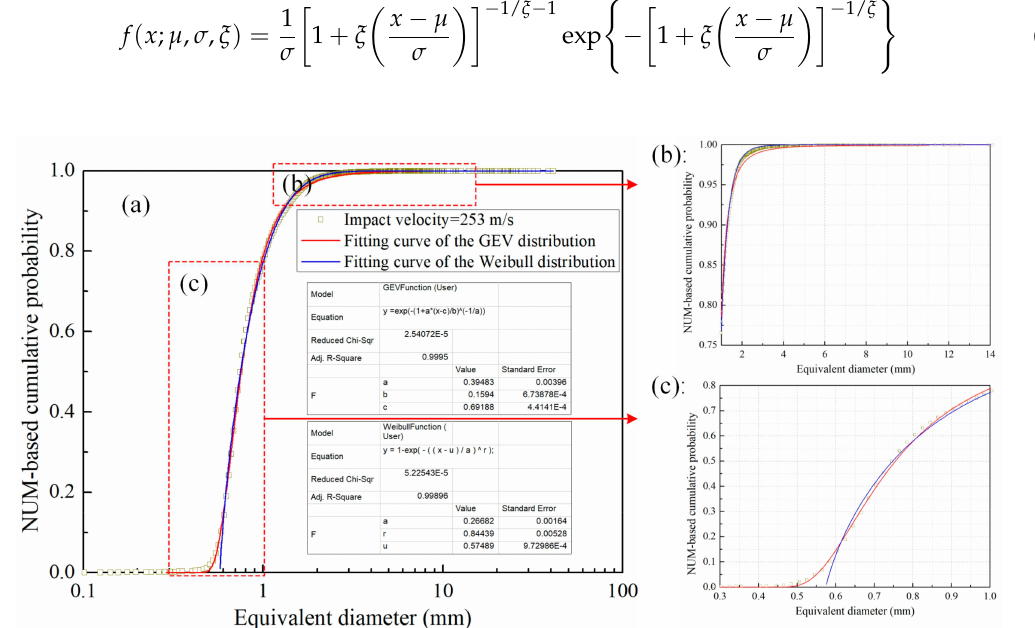
Figure 6. Fitting curves of the cumulative probability of coal fragments based on the GEV distribution function and Weibull distribution function (impact velocity = 253 m/s). ( a ) The fitting curves of all the particle sizes, ( b ) and ( c ) is the partial magnification of fitting curves for the large and small particle sizes,